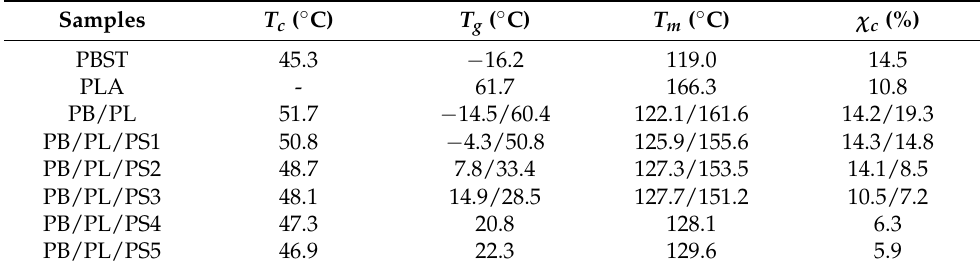
Figure 2. DSC curves of neat PBST, PLA, and PBST/PLA blends with various amounts of PSMA: ( a ) cooling and ( b ) the second heating. Table 2. DSC data for PBST/PLA